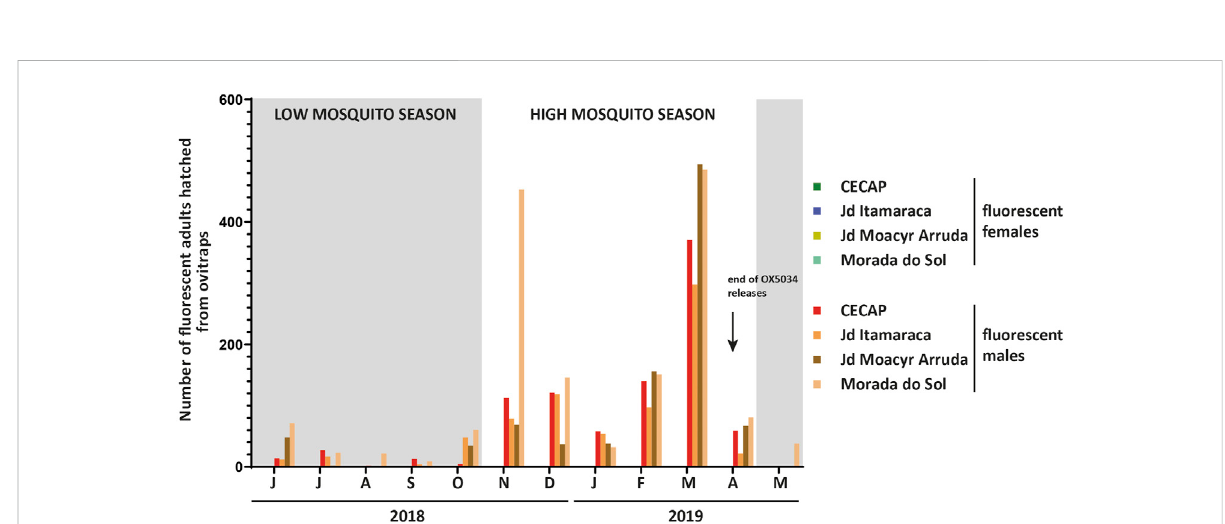
FIGURE 5 Number of fl uorescent adults hatched from ovitraps-collected eggs from OX5034-treated areas, Indaiatuba, São Paulo State, Brazil. Each bar represents fl uorescent adults from one of the four fi eld sites (CECAP, Jardim Itamaracá, Jardim Moacyr Arruda, Morada do Sol). Low mosquito seasons (May-October) are shown with grey boxes. No fl uorescent females were obtained from any ovitrap-collected eggs at any time throughout the 2018 – 2019 fi eld trial of OX5034 Aedes aegypti . Data are reported as totals for each calendar monththroughout the OX5034 Aedes aegypti release